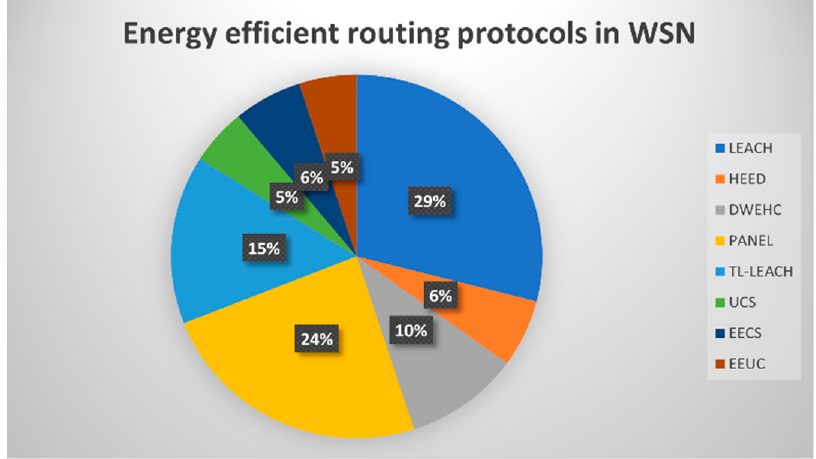
Figure 6. Classification of energy-efficient routing protocols.